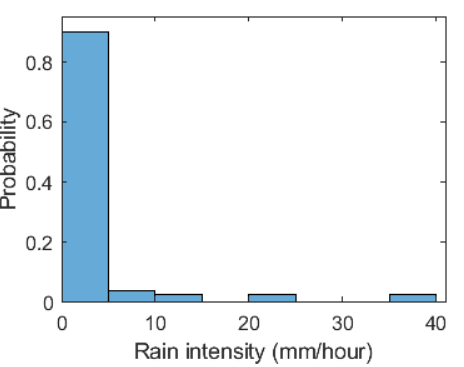
Figure A2. Histogram of the rain intensity for the Rain samples. In most cases the rain intensity was less than 5 mm/h.